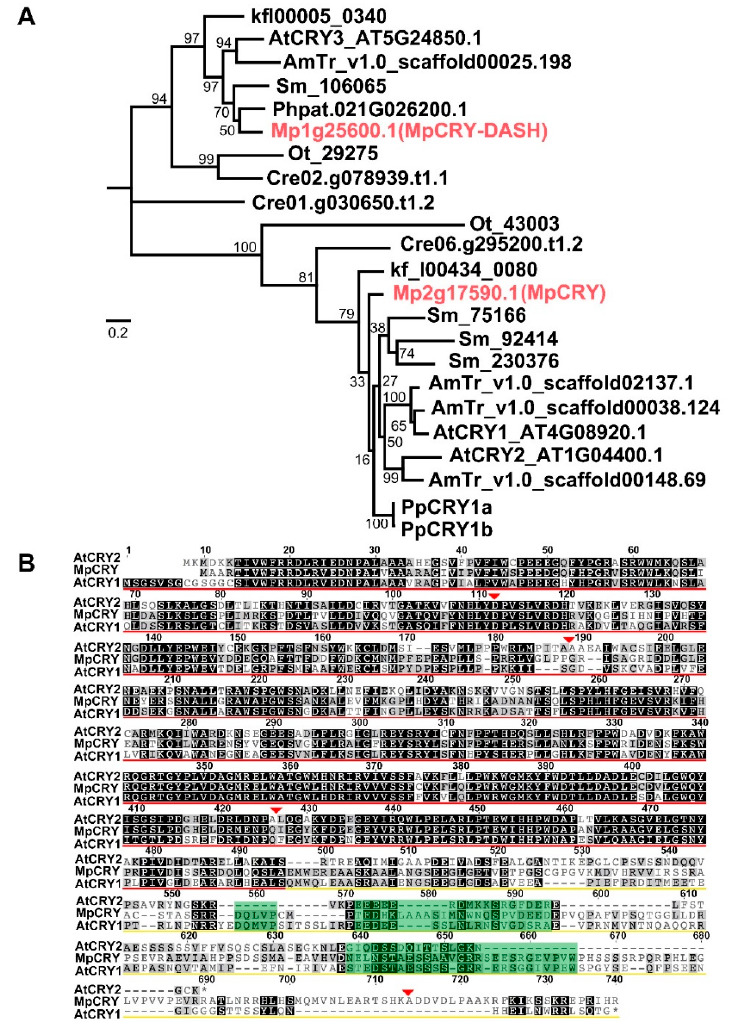
Figure 1. Phylogenetic analysis of cryptochromes from green algae and land plants. ( A ) Phylogenetic relationships of plant cryptochromes. The tree was constructed using 23 cryptochromes from various plant species. The Ostreococcus lucimarinus Ot_43003 sequence was used as the outgroup. Poste- rior probabilities are indicated at the nodes. At, Arabidopsis thaliana; AmTr , Amborella trichopoda; Sm, Selaginella moellendorffii; Pp/Phpat, Physcomitrium patens ; Mapoly , Marchantia polymorpha ; Kf, Klebsormidium nitens ; Cre, Chlamydomonas reinhardtii ; Ot, Ostreococcus lucimarinus . Bar indicates 0.1 sub- stitutions per site. ( B ) Alignment of amino acid sequences of cryptochromes from M. polymorpha and A. thaliana . Identical and similar amino acid residues are highlighted with black and gray boxes, respectively. Red and yellow underlines indicate N-terminal PHR domain and CCE domain, re- spectively. Green background sequences indicate the DAS domain. Red inverted triangles indicate positions corresponding to intron insertion in the genes. * indicates the end point of the amino acid